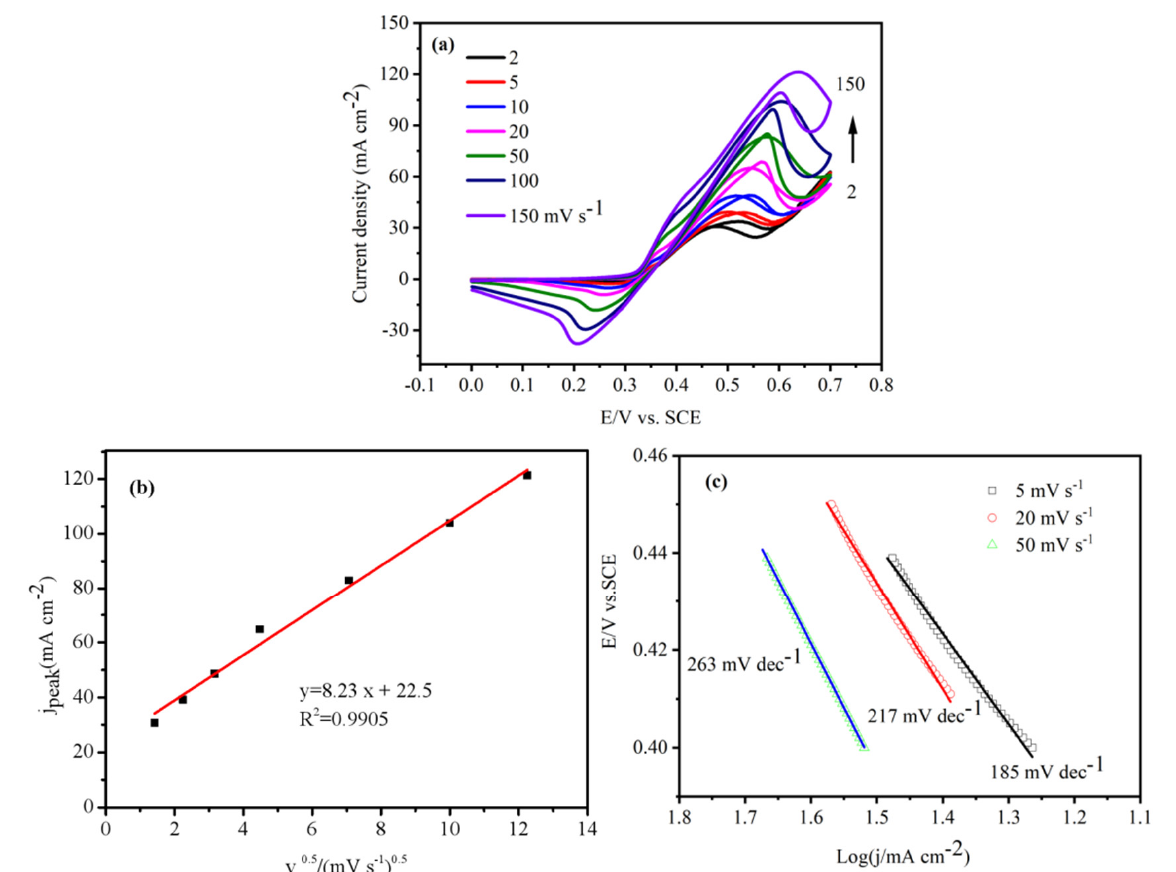
Figure 6. ( a ) The comparison of CV curves for NiCuOOH-NF electrode in 2.0 M NaOH + 0.2 M NH 4+ at different scan rates of 2, 5, 10, 20, 50, 100, 150 mV s − 1 . ( b ) Variation of the peak anode current with the square root of the scan rate. ( c ) Tafel plots of NiCuOOH-NF electrode at 5, 20, and 50 mV s − 1 scan rates.